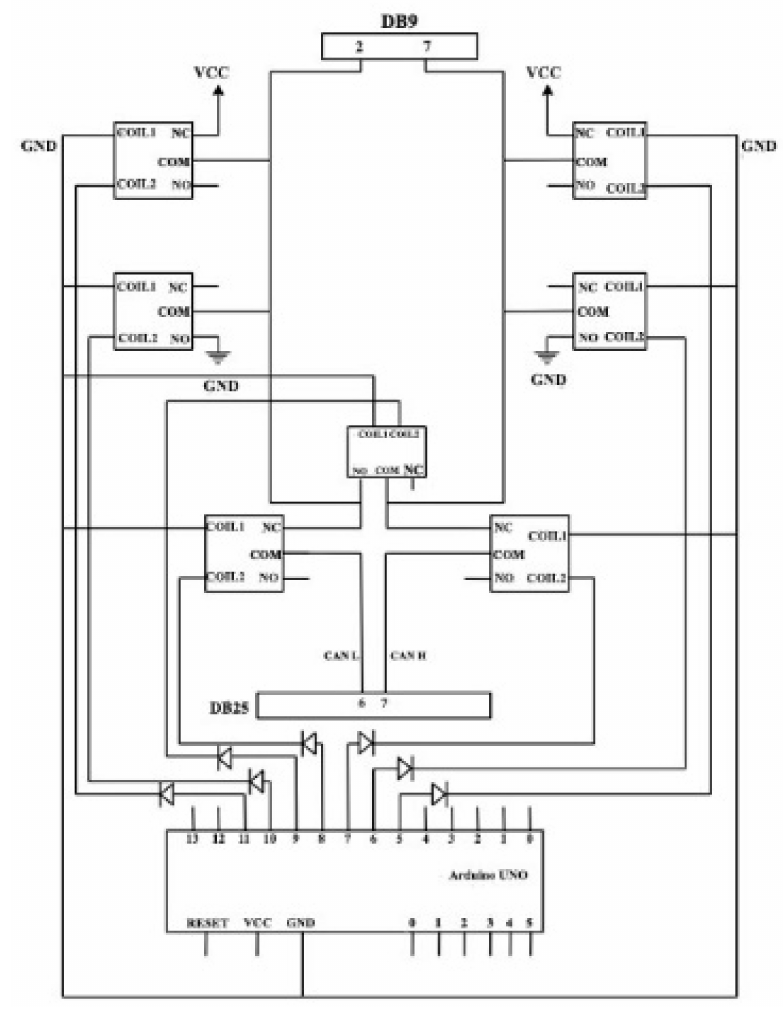
Figure 13. Buss-off and overload functionality.